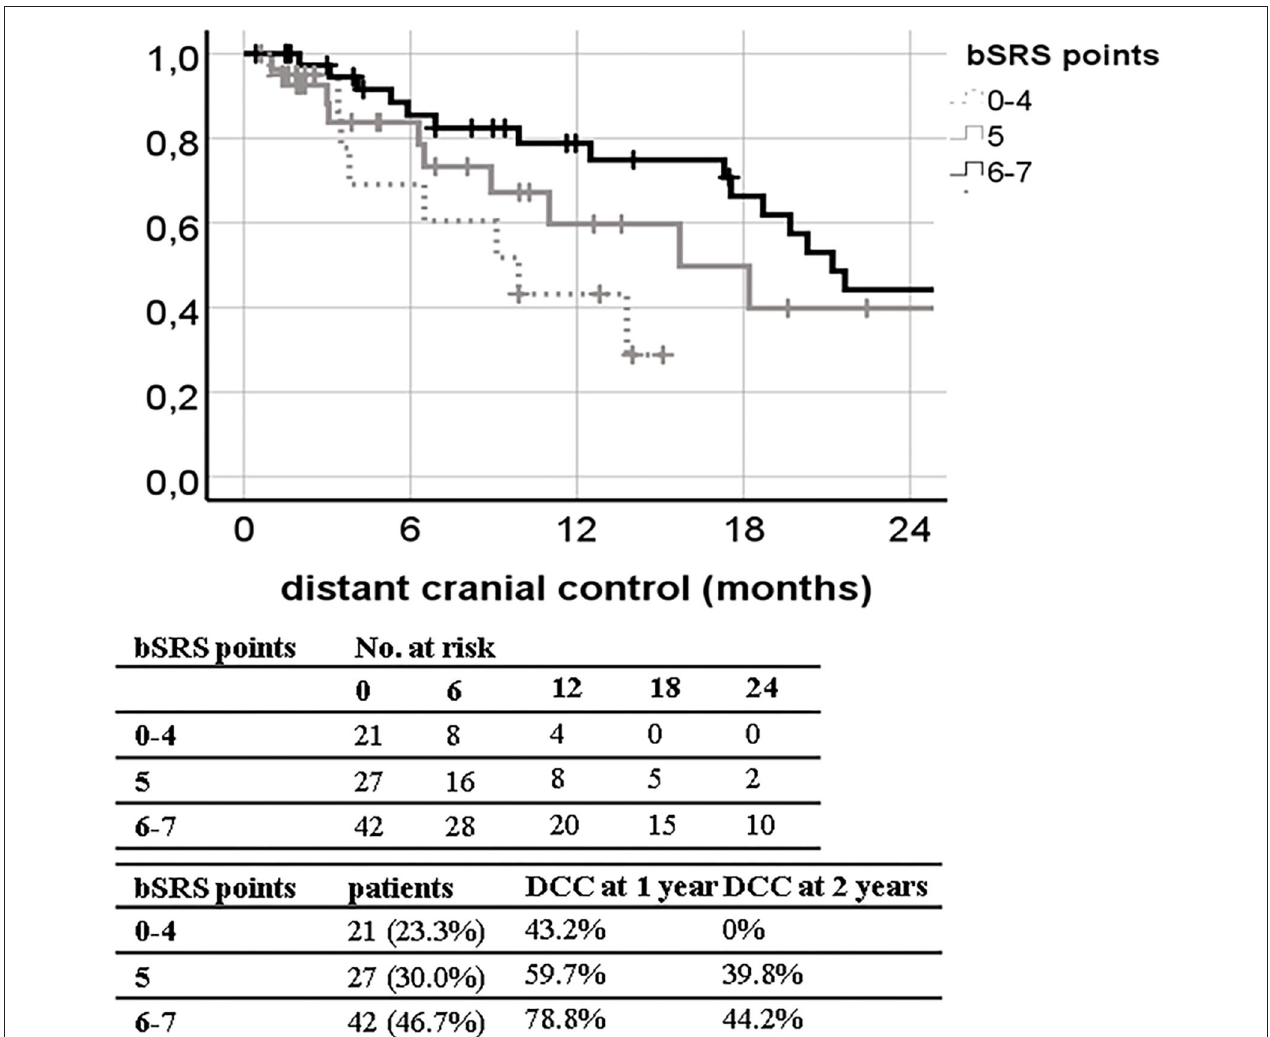
FIGURE 5 | Kaplan–Meier curves for distant cranial control (DCC; n = 90) divided by the breast scoring tool for stereotactic therapy (bSRS) in our patient population (log-rank p = 0.036; concordance index 0.482; 95% CI, 0.359–0.604; p = 0.771) with 1- and 2-year DCC